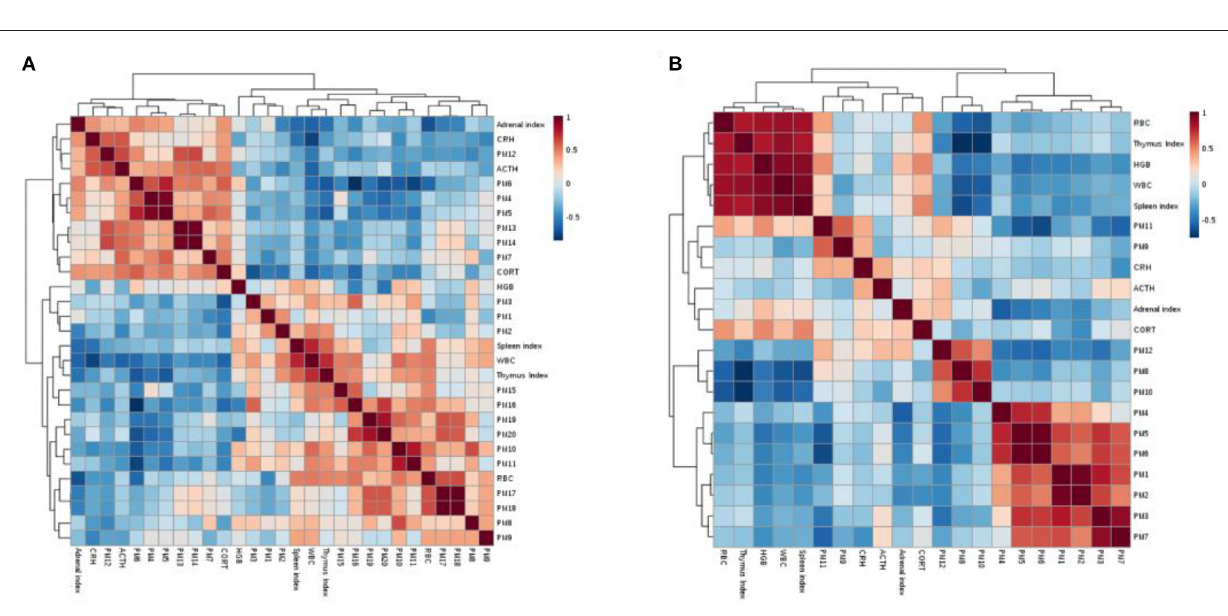
the immune system (43). Red blood cells, white blood